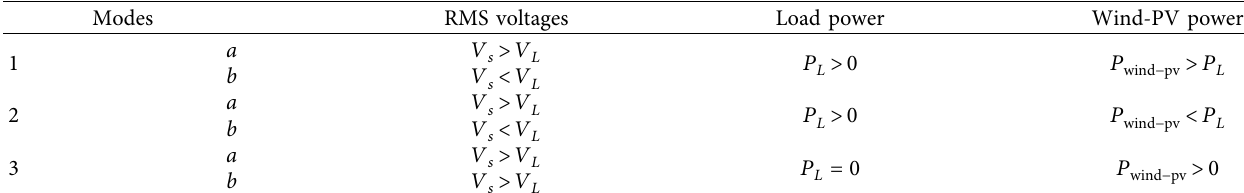
Table 1: Conditions assumed to regulate the flow of active power by the Wind-PV-UPQC.